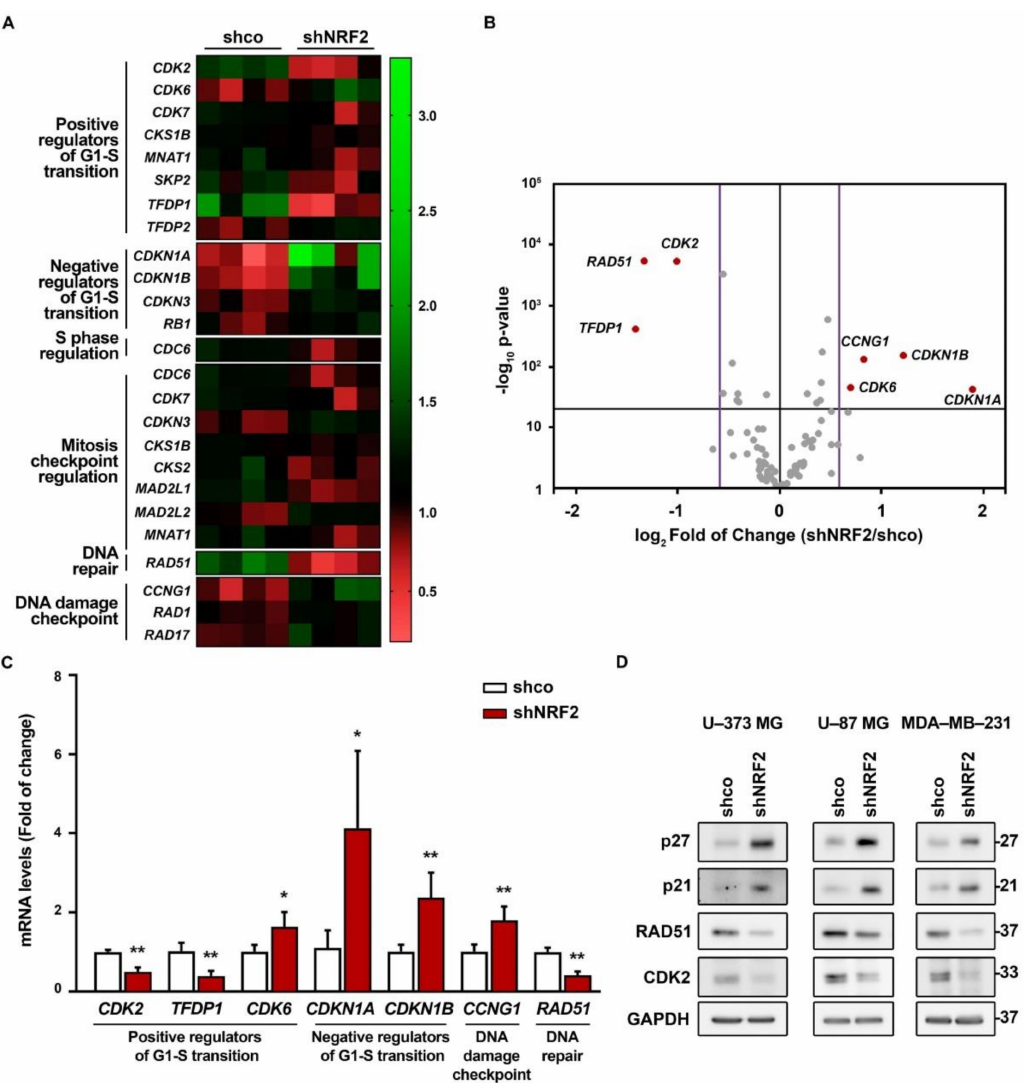
Figure 6. NRF2 absence alters the expression of several genes implied in cell cycle progression. U–373 MG cells were transduced with lentiviral vectors containing control (shco) or shNRF2–1 (shNRF2). ( A ) Changes in expression of 25 out of 84 different genes implied in cell cycle regulation analyzed through RT 2 Profiler PCR Array Human Cell Cycle from Qiagen for shco and shNRF2 U–373 MG cells. The 20 genes with significant changes in their expression ( p -value ≤ 0.05) were grouped by their biological function in a heat map, representing the individual fold of change compared to the media of all eight samples; ( B ) Volcano plot representing p -value (calculated through a Student’s t -test of shNRF2 vs. shco, n = 4) and fold of change for the differences in gene expression between shco and shNRF2 cells. The p -value threshold was established to be less than 0.05 (black horizontal line), while the fold of change threshold was established at 1.5/0.66 (purple vertical lines). Genes surpassing both thresholds are shown in red with their respective names, while the rest of the genes are represented in grey; ( C ) Changes in gene expression in genes with a p -value lower than 0.05 and a fold of change higher than 1.5 or lower than 0.66. Data are presented as mean ± S.D. ** p ≤ 0.01; * p ≤ 0.05 vs. shco according to a Student’s t -test ( n = 4); ( D ) Representative immunoblot analysis of p21, p27, RAD51, CDK2, and GAPDH as a loading control in lysates from U–373 MG, U–87 MG, and MDA–MB–231 cells transduced with lentiviral vectors containing control (shco) or shNRF2–1